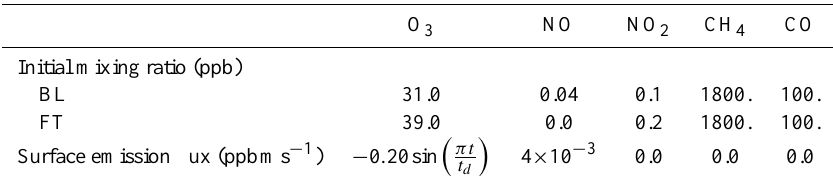
Table 5. Initial mixing ratios in BL and FT and surface emission fluxes of the reactants as obtained from fitting MXLCH-SOA to the case study observations. Species in the reaction mechanism that are not included in this table have zero initial concentrations and zero surface emissions, except TERP and ISO (see Table 3). For the molecules O 2 and N 2 , we have imposed the values 2 × 10 8 and 8 × 10 8 ppb, respectively.